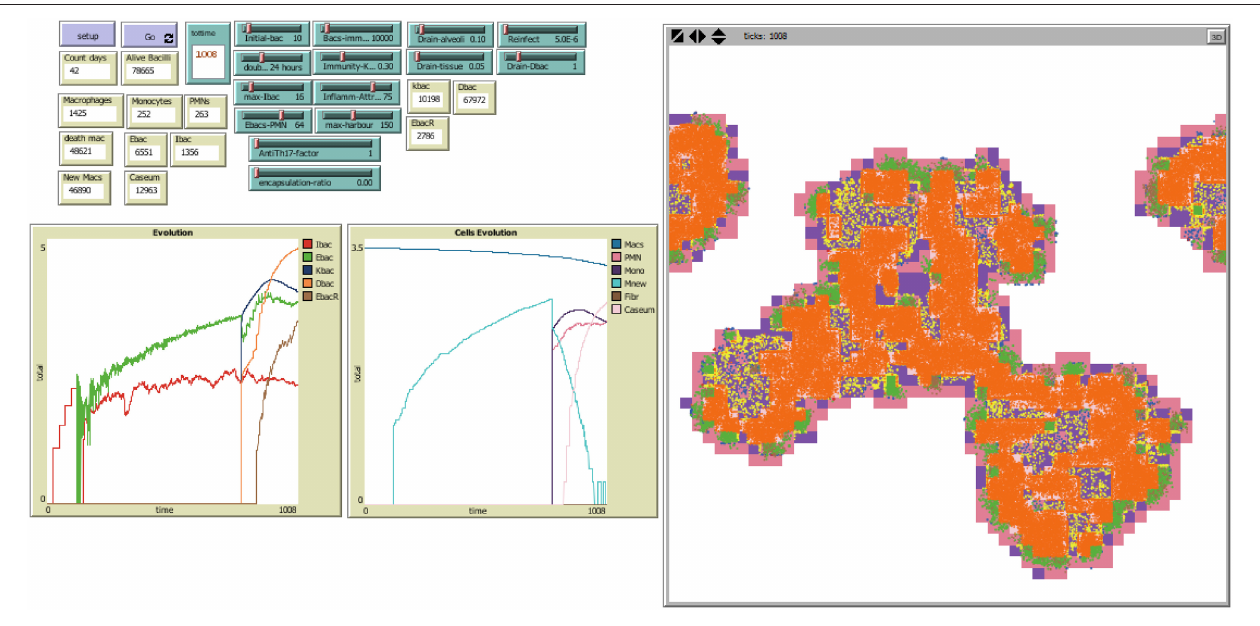
FIGURE 2 | NetLogo’s user interface, with model TBPATCH. Green sliders are the parameters that can be changed by the user. Brown boxes show the evolution of different variables during a simulation. The left window is the world representation, where spatial evolution of the infection can be seen. Colors: Alveoli: White : when a single AM is present; Black : when the AM is destroyed; Blue : when the AM is destroyed and replaced by another AM from the interstitium; Violet : when an activated AM (aAM) is present; Pink : when PMNs occupy the alveoli; Brown : capsule. Bacilli: Blue challenge bacilli; Red : Intracellular bacilli (Ibac); Green : Extracellular (Ebac); Brown : growing Ebac; Orange : dormant (Dbac); Yellow : killed bacilli